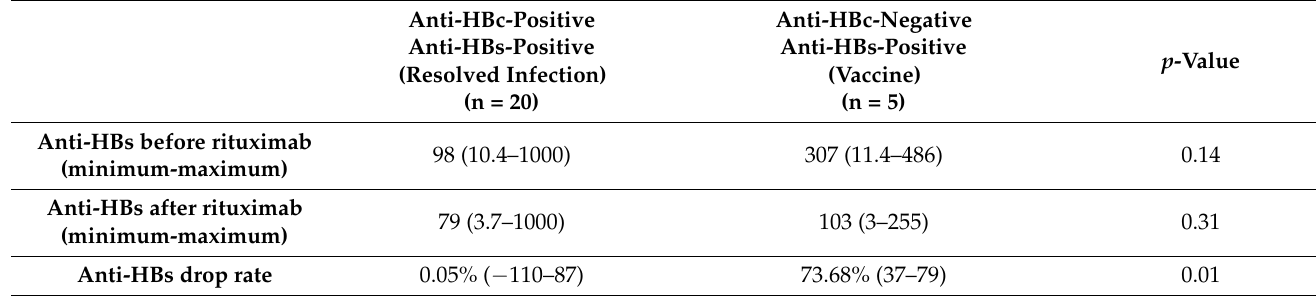
Table 4. Comparison of anti-HBs titers and drop rate categorized by the etiology of anti-HBs.